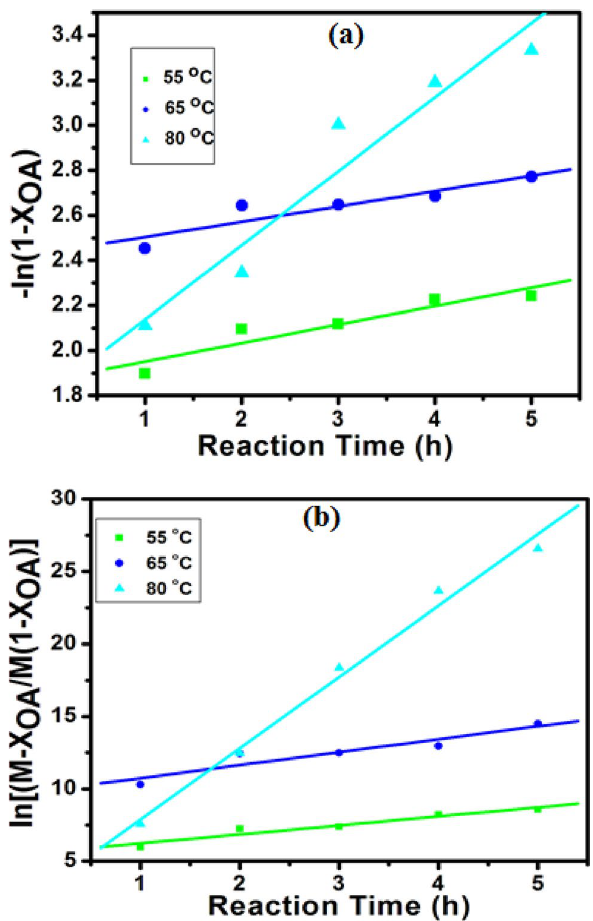
Figure 10. Fitting the kinetic models ( a ) PFO ( b ) second-order models for esterification of OA. The reaction condition: 4.0 wt% catalyst loading; methanol/OA molar ratio of 8:1 and 5 h reaction time.